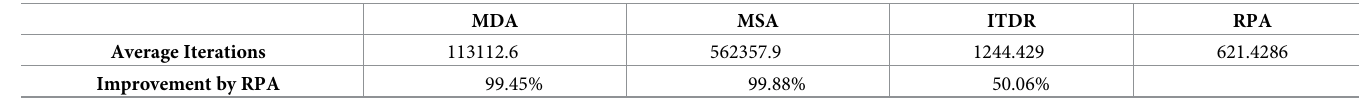
Table 15. Average percentage improvement of iterations by RPA technique.